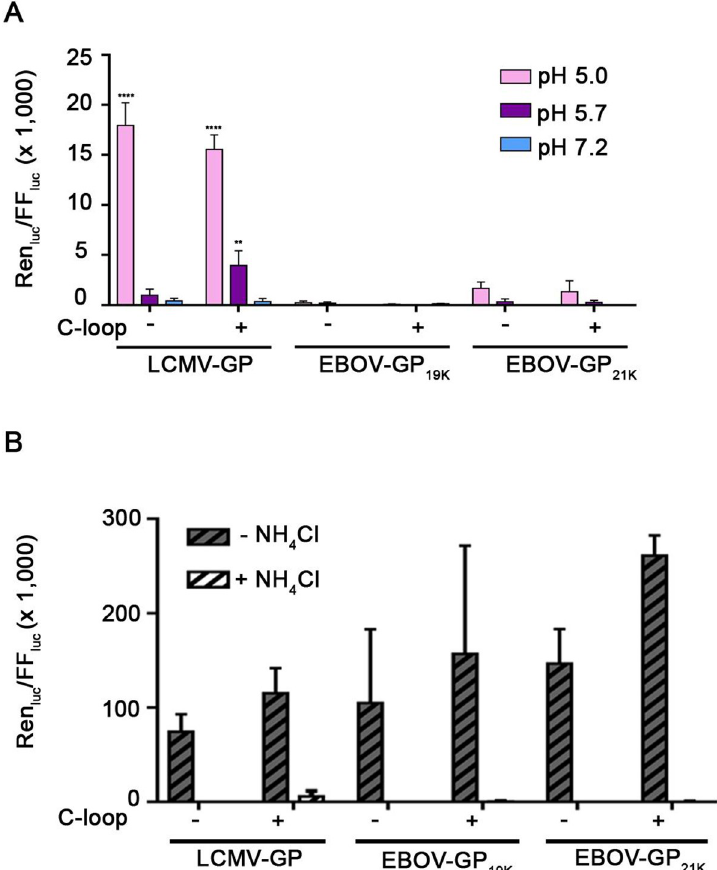
Fig 2. NPC1-C-loop and low pH and are not sufficient to trigger detectable forced fusion at the plasma membrane (FFPM) by infectious pseudoviruses bearing EBOV-GP cl . (A): VSV pseudoviruses bearing the indicated GP were bound at 4˚C to target (COS7) cells with (+) or without (-) NPC1-C-loop at their surface that had been pre-cooled (to prevent pseudovirus internalization). The cells were then pulsed at pH 5.0, 5.7 or 7.2 for 5 min at 37˚C after which time the buffer was replaced with pH 7.4 medium containing 40 mM NH 4 Cl to raise endosomal pH. (FFPM was not monitored at pH 4.5 due to excessive cell loss.) After 24 h, cells were lysed and assessed for the ratio of Renilla luciferase (virus entry and replication) over firefly luciferase (total cells), as described in the Methods section. (B): VSV pseudoviruses bearing the indicated GP (equal input as for the FFPM experiment in A ) were added to COS7 cells (+/- C-loop, as indicated) as described above and then either mock-treated or treated with 40 mM NH 4 Cl, as indicated. The cells were then incubated at 37˚C for 24 h and analyzed for Renilla divided by firefly luciferase as in A . Data represent averages +/- SEM from four independent experiments each performed with triplicate